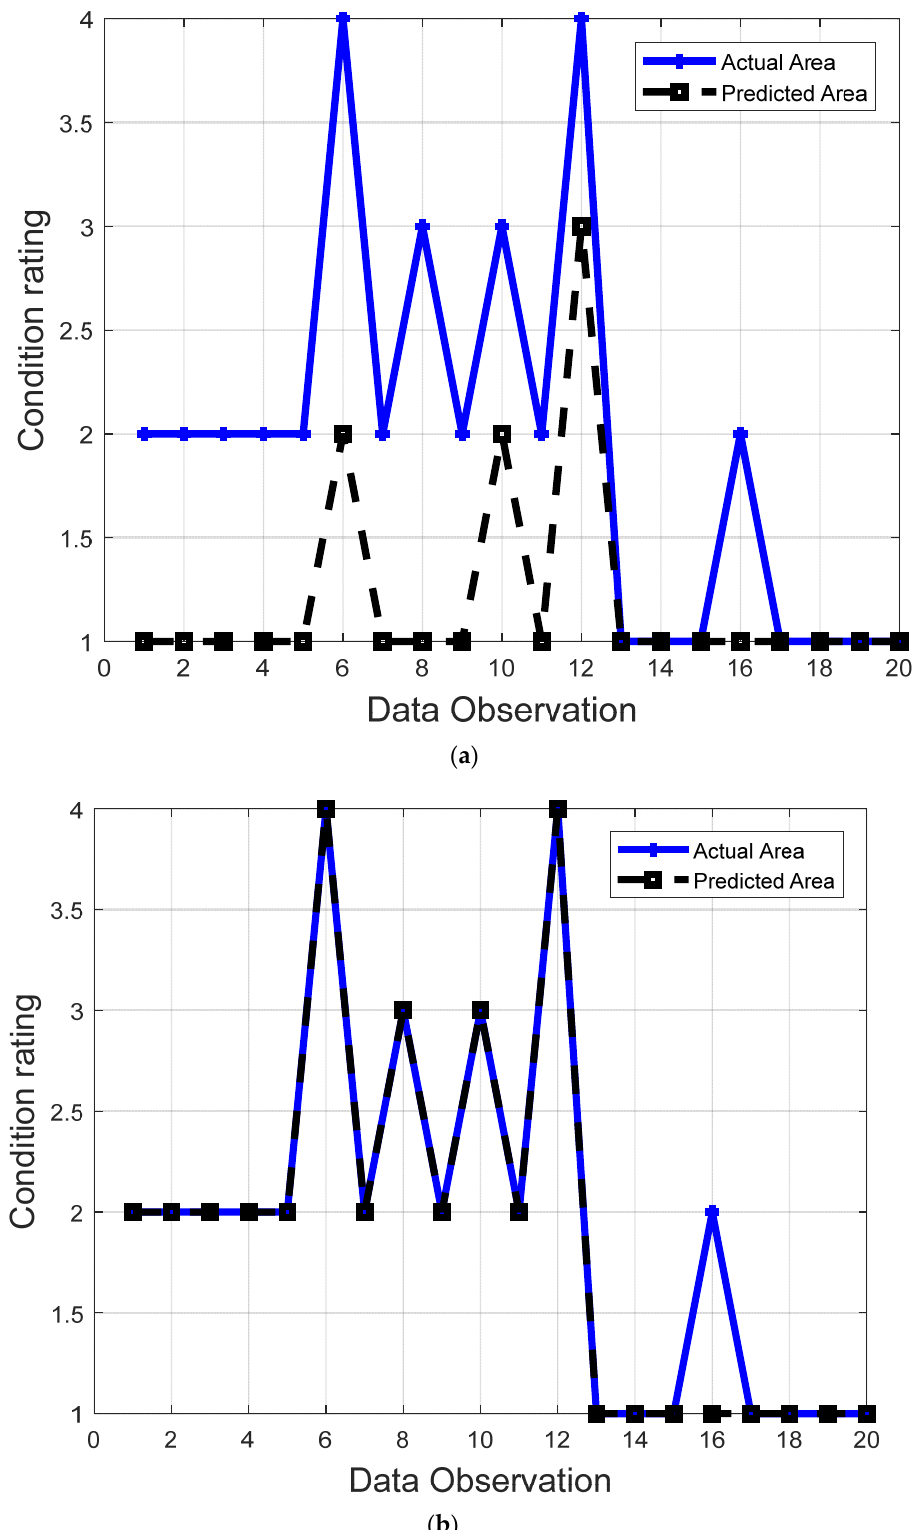
Figure 5. Visualization of the prediction performances of the back-propagation artificial neural network and the developed GWO − GPR model. ( a ) Back-propagation artificial neural network. ( b ) Developed GWO − GPR model.